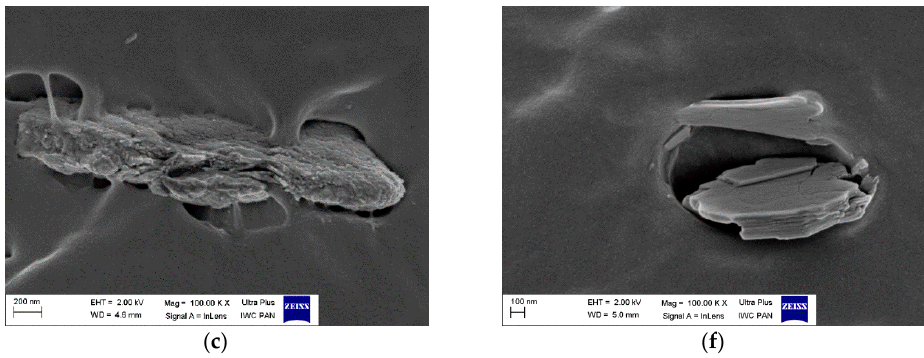
Figure 14. Scanning electron micrographs of ( a,b,c ) NBR and ( d,e,f ) EPM composites filled with 10 phr of hybrid pigment at different magnifications.